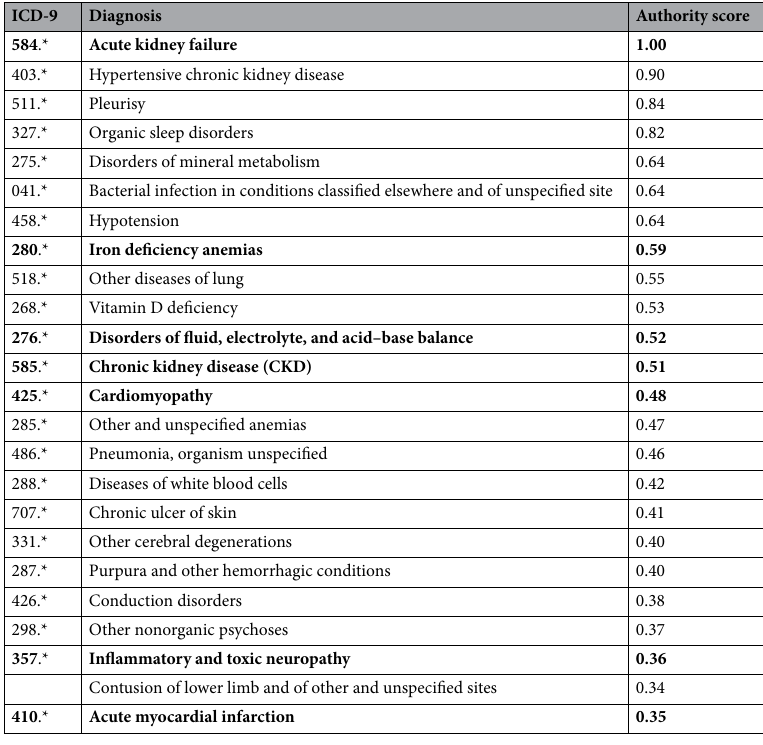
Table 4. Highest authority score diagnosis codes (n = 142). Bold denotes diagnoses that are among both top hubs and